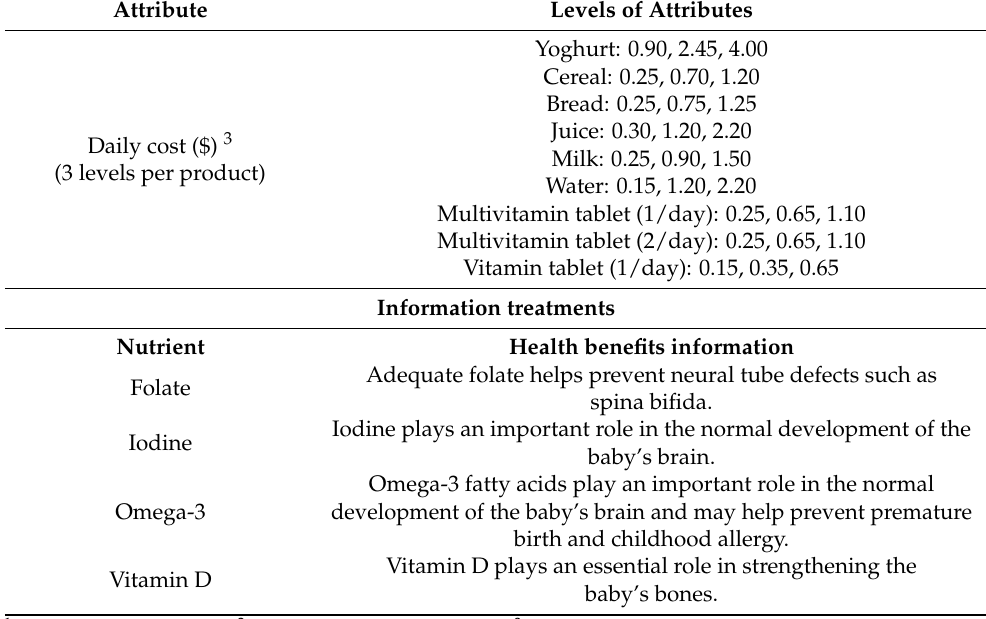
1 Table adapted from [27]; 2 Alternative-specific attribute; 3 Product-specific